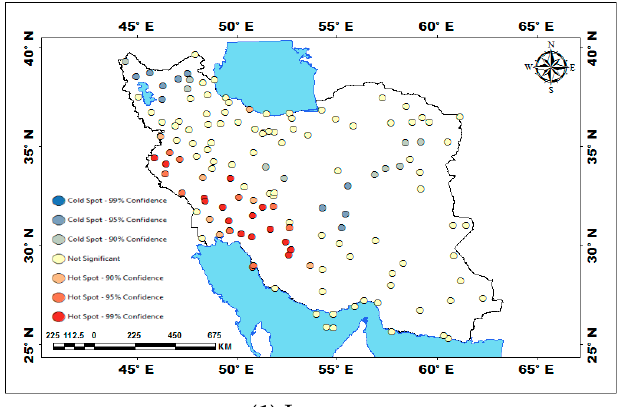
Table 10. Moran’s I autocorrelation statistics in Iran.